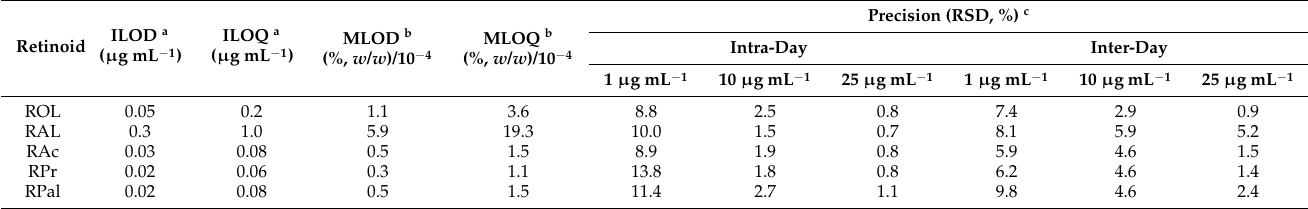
Table 3. Analytical figures of merit of the developed